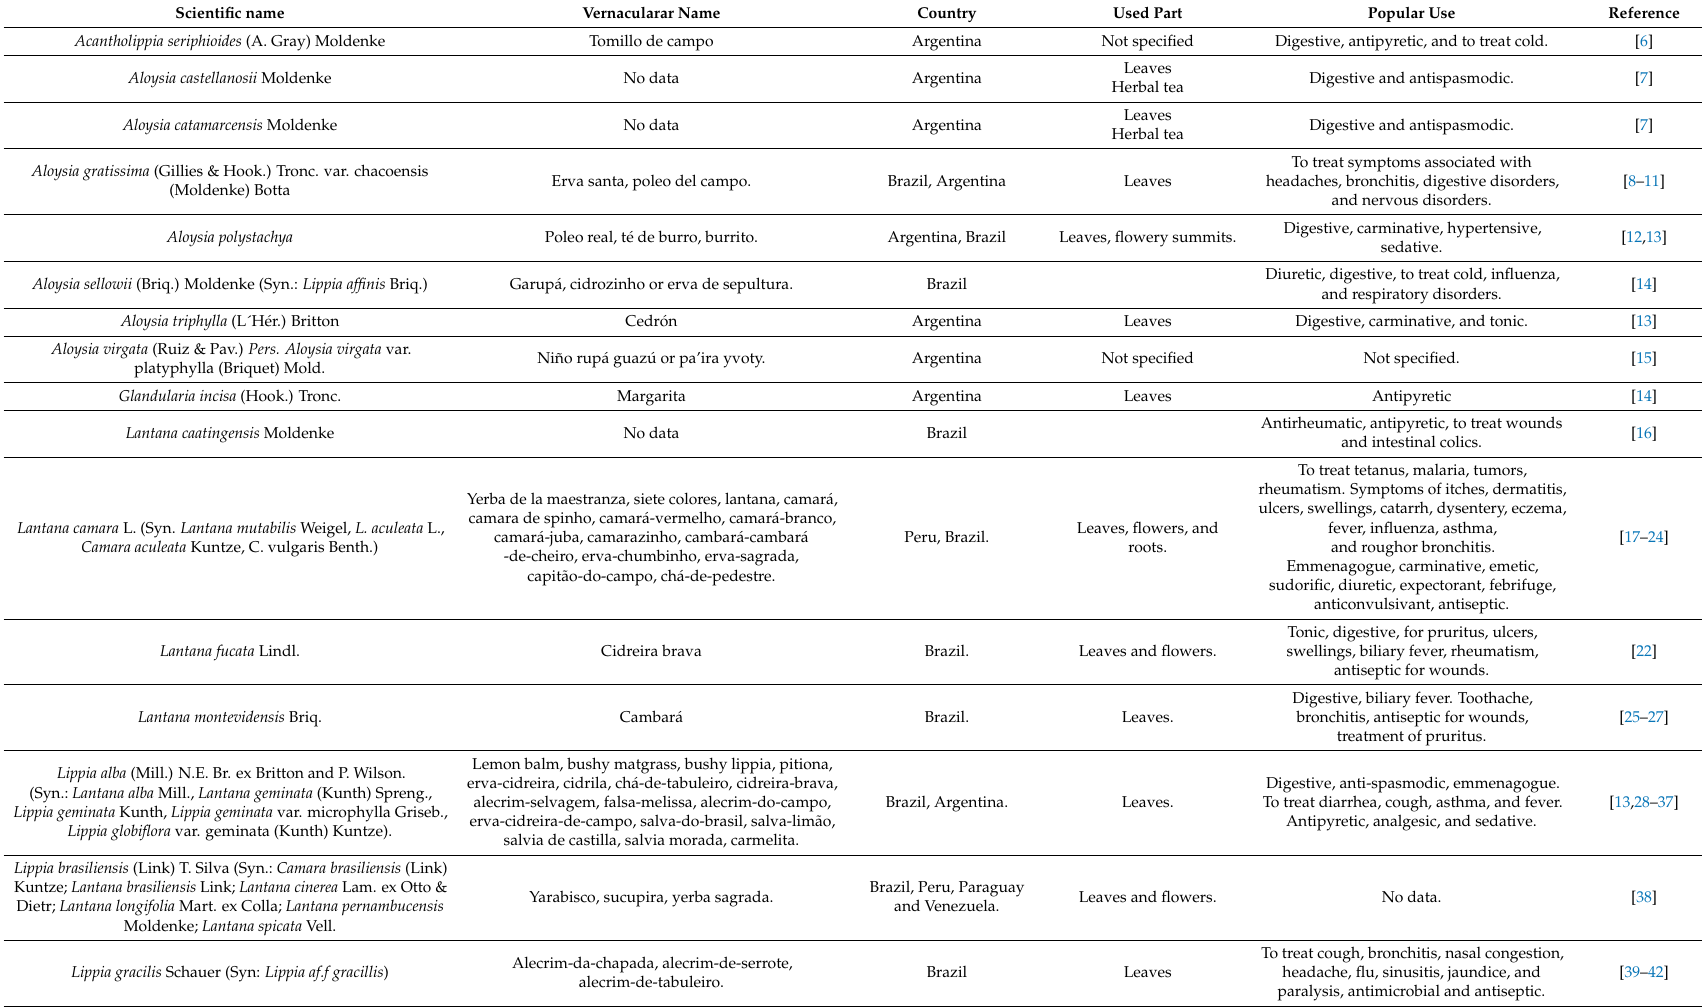
Table 1. Ethnobotany of Verbenaceae family